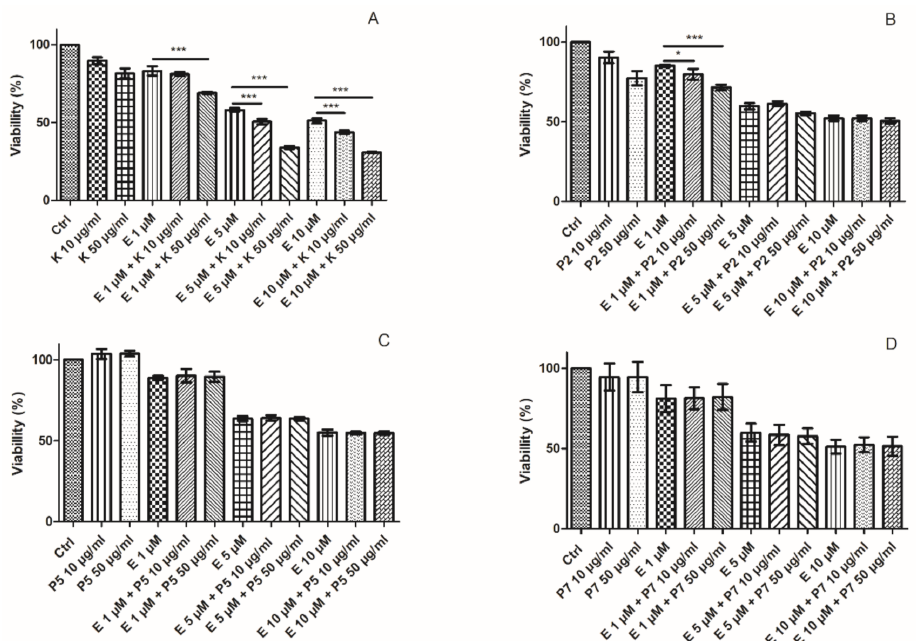
Figure 2. Viability of HL-60 cells determined by resazurin reduction assay after 24 h treatment with 1–10 µ M etoposide (E) and 10-50 µ g/mL kaempferol (K) ( A ), P2 ( B ), P5 ( C ) and P7 ( D )